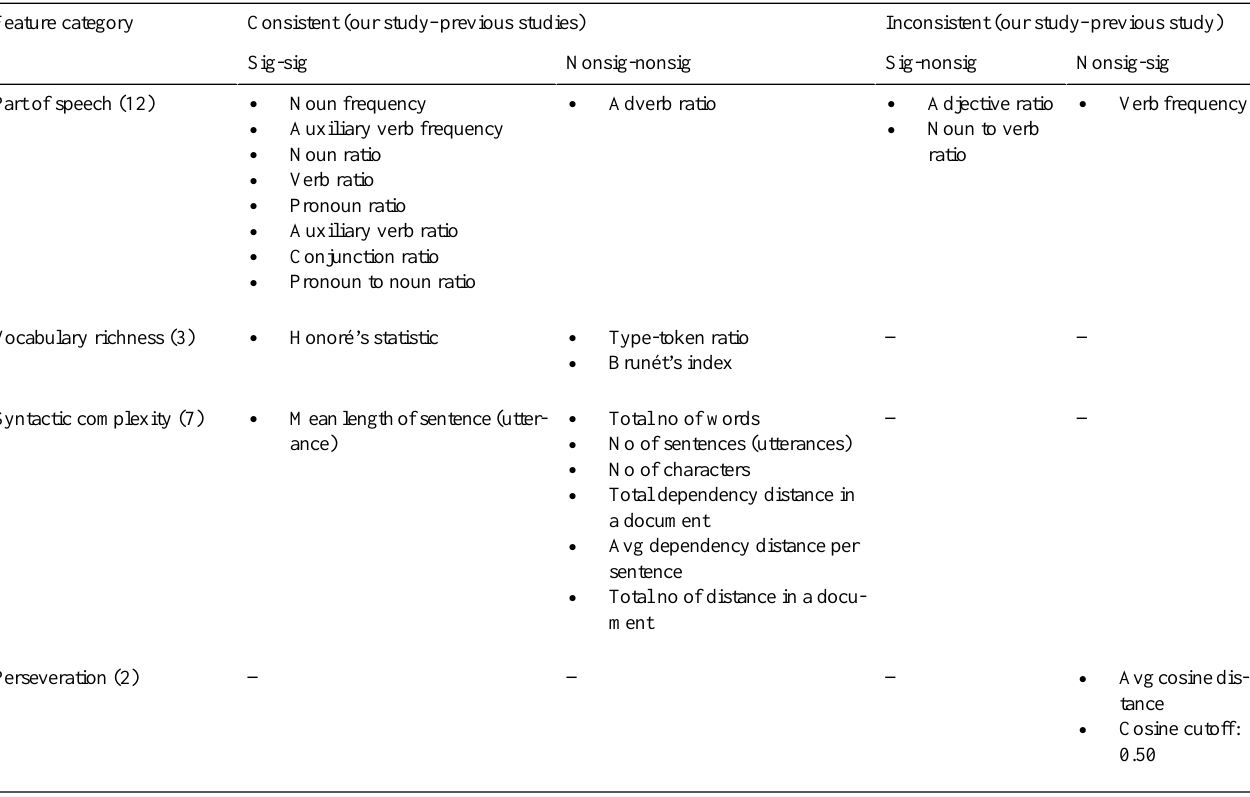
Table 3. Comparison of the results of statistical analysis for the linguistic features between our study and previous studies. Our study analyzes speech data during daily conversations, while the previous studies analyzed connected speech data during neuropsychological tests. Sig and nonsig refer to significant and nonsignificant. For example, sig-nonsig in the inconsistent column indicates a feature that showed significant difference in the previous studies but not in our study. Cells contain the name of the corresponding features. Features whose statistical test results were not reported in the previous studies are excluded from this summary table. Information including P values of the statistical analysis in our study and the list of the previous studies is provided in Multimedia Appendix 1. Inconsistent (our study–previous study)Consistent (our study–previous studies)Feature category Nonsig-sigSig-nonsigNonsig-nonsigSig-sig Part of speech